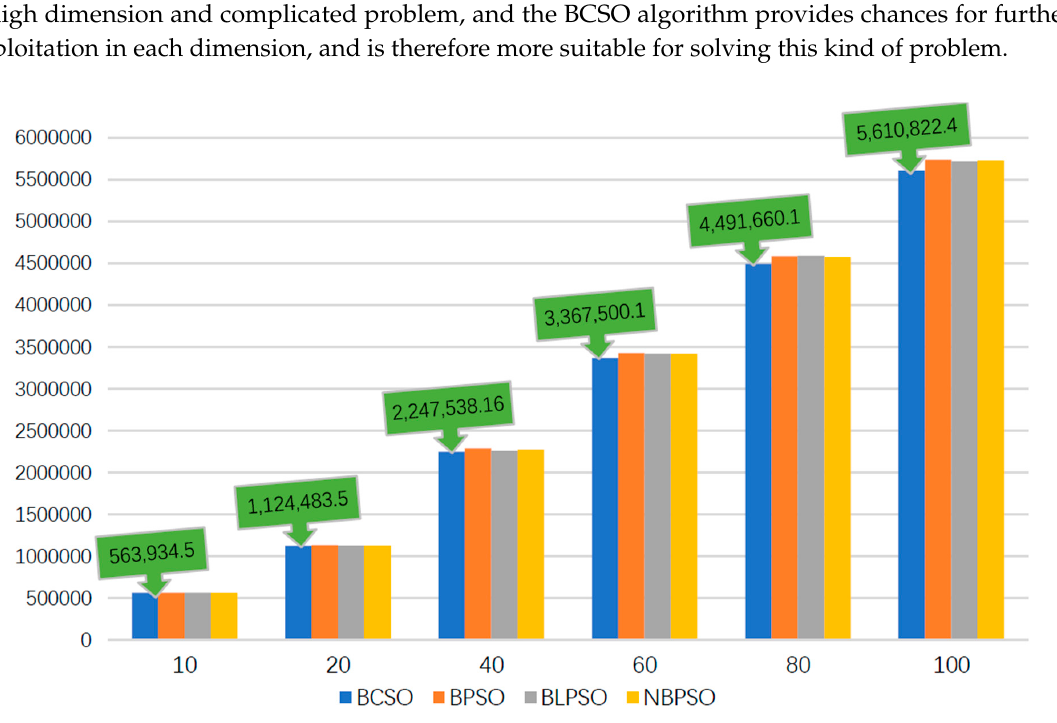
Figure 2. The mean comparison of different methods for different unit scales. BCSO: Binary competitive swarm optimizer; BPSO: Binary particle swarm optimization; BLPSO: Best parallel particle swarm optimization; NBPSO: New binary particle swarm optimization.